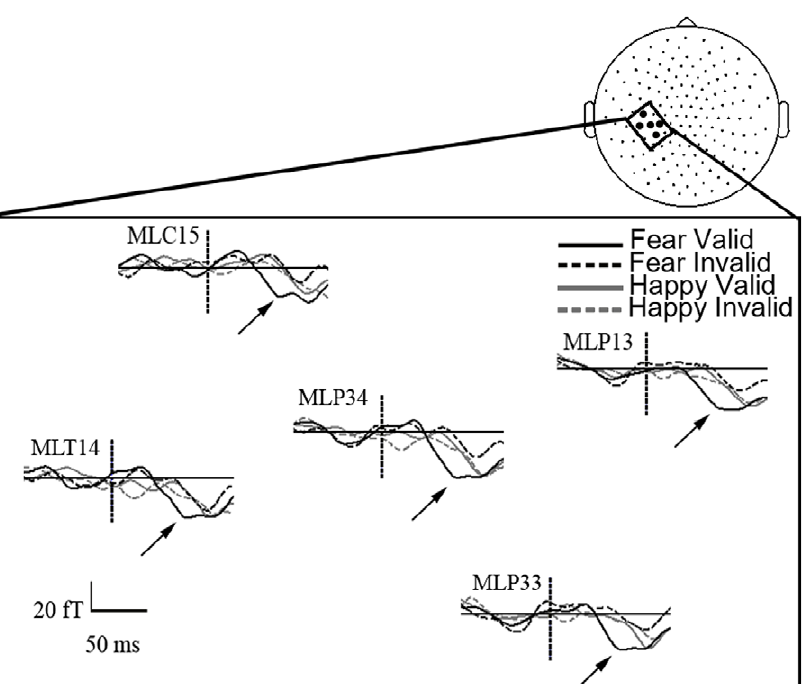
Figure 3. Time course of the attention orienting effect induced fearful gaze. The time course of the grand-averaged ERFs is represented on the five sensors of interest, under the 4 experimental conditions of cue-target validity and emotion.